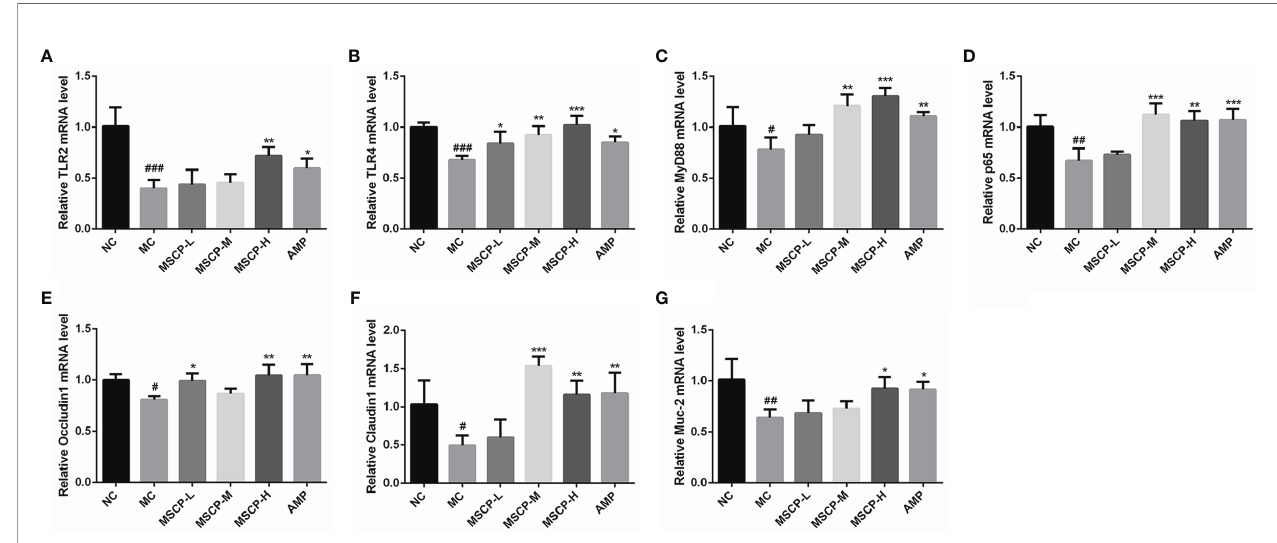
FIGURE 9 | Effects of the treatments of MSCP (100, 200 and 400 mg/kg· BW/d, respectively) and AMP (400 mg/kg· BW/d) on the relative mRNA expression of (A) TLR2, (B) TLR4, (C) MyD88, (D) p65, (E) Occludin1, (F) Claudin1 and (G) MUC-2 in small intestine tissues. Data are expressed as mean ± SD. # p < 0.05, ## p < 0.01, ### p < 0.001 compared with NC group; * p < 0.05, ** p < 0.01, *** p < 0.001 compared with MC group.